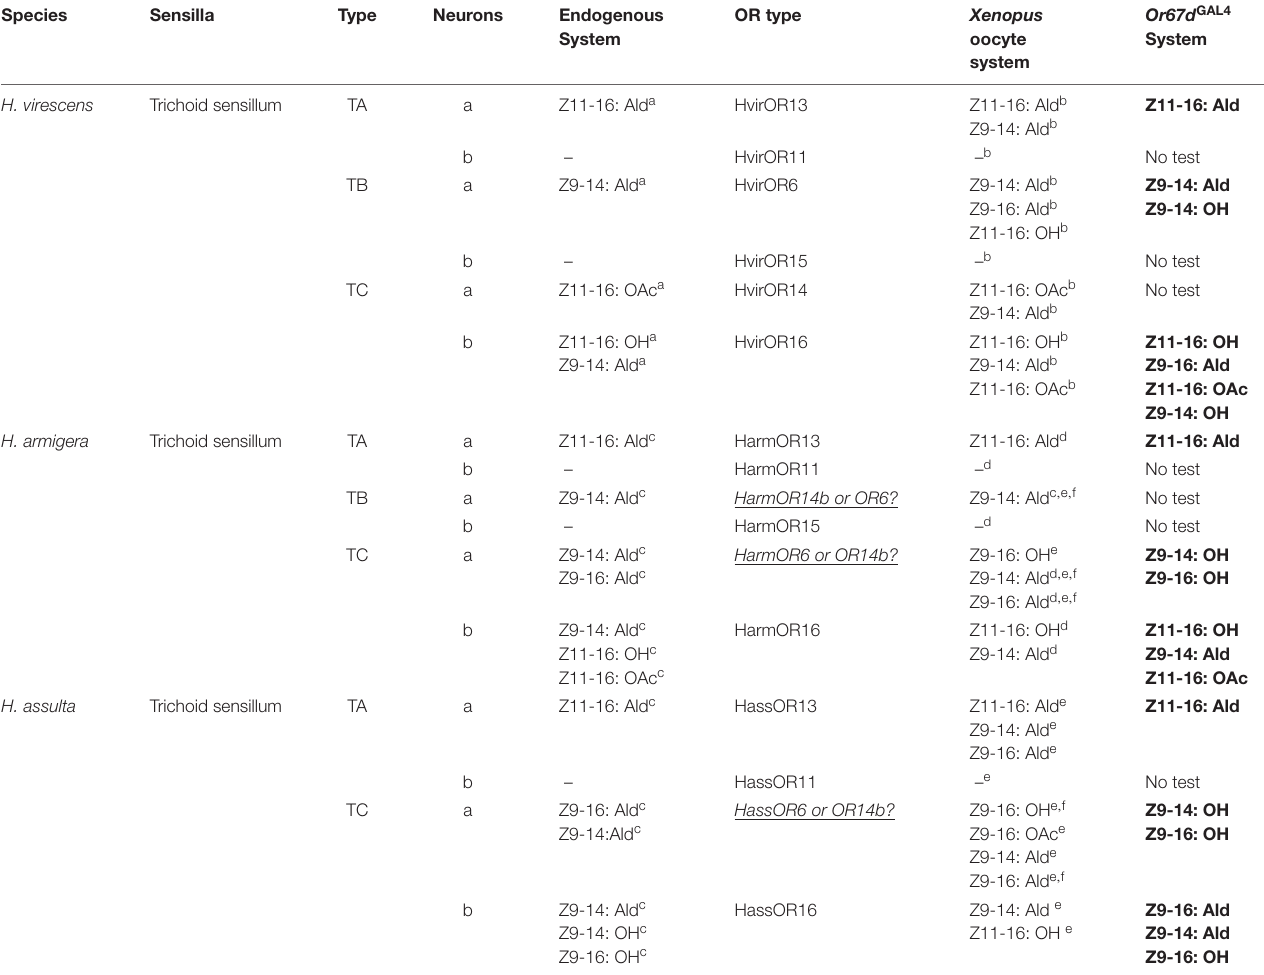
TABLE 1 | The comparison of functional characterizations between neurons and odorant receptors. Species